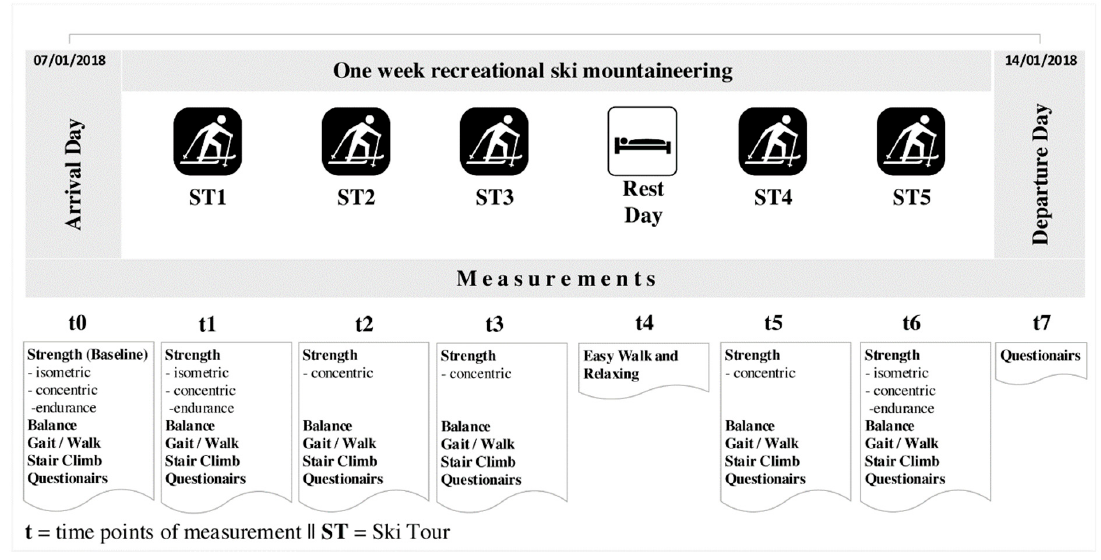
Figure 1. A schematic of the chronological process of the trial.